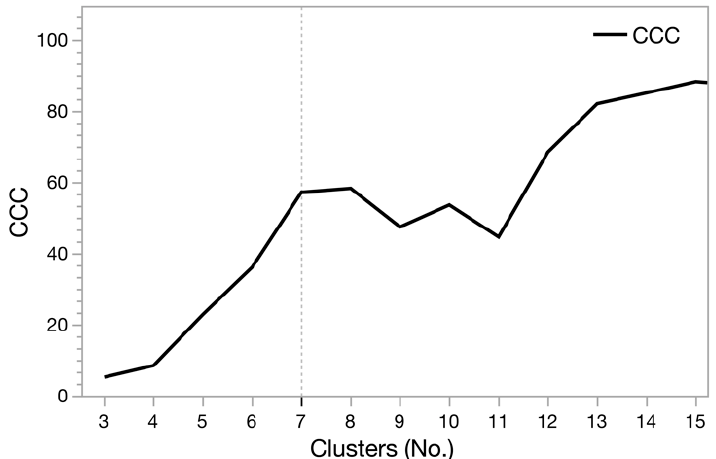
Figure A1. Number of potential K-means clusters and corresponding cubic clustering criterion (CCC) values, which show explained variation (variance-stabilized Rsquare values). Positive CCC values indicate possible clustering and values greater than 2 or 3 represent good clustering (SAS, 2022). Dotted line shows selection cutoff (elbow method) after also considering model parsimony and diminishing returns.